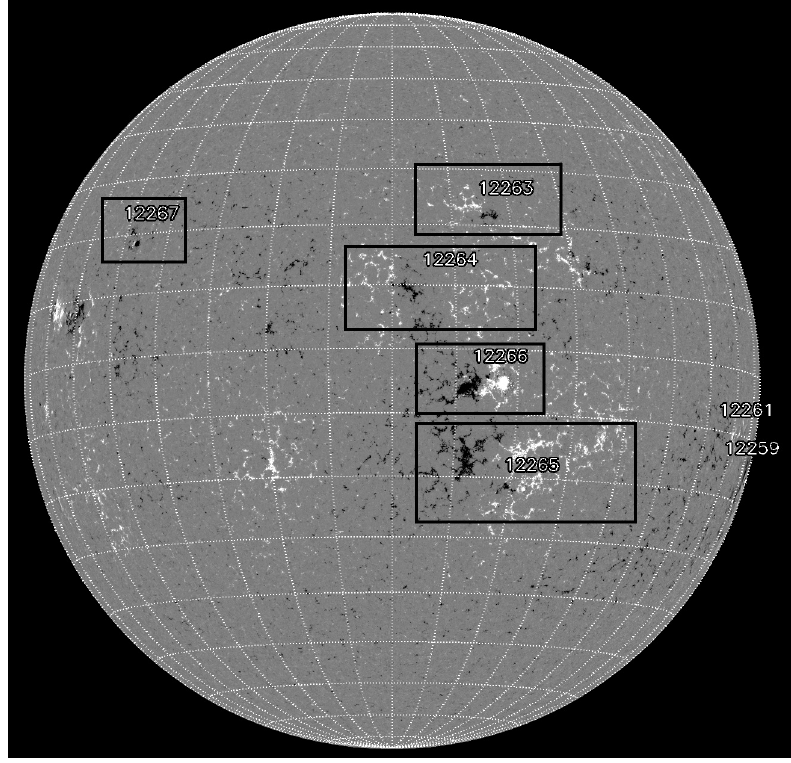
Figure 1. Full-disk magnetogram with labeled active regions (on 20 January